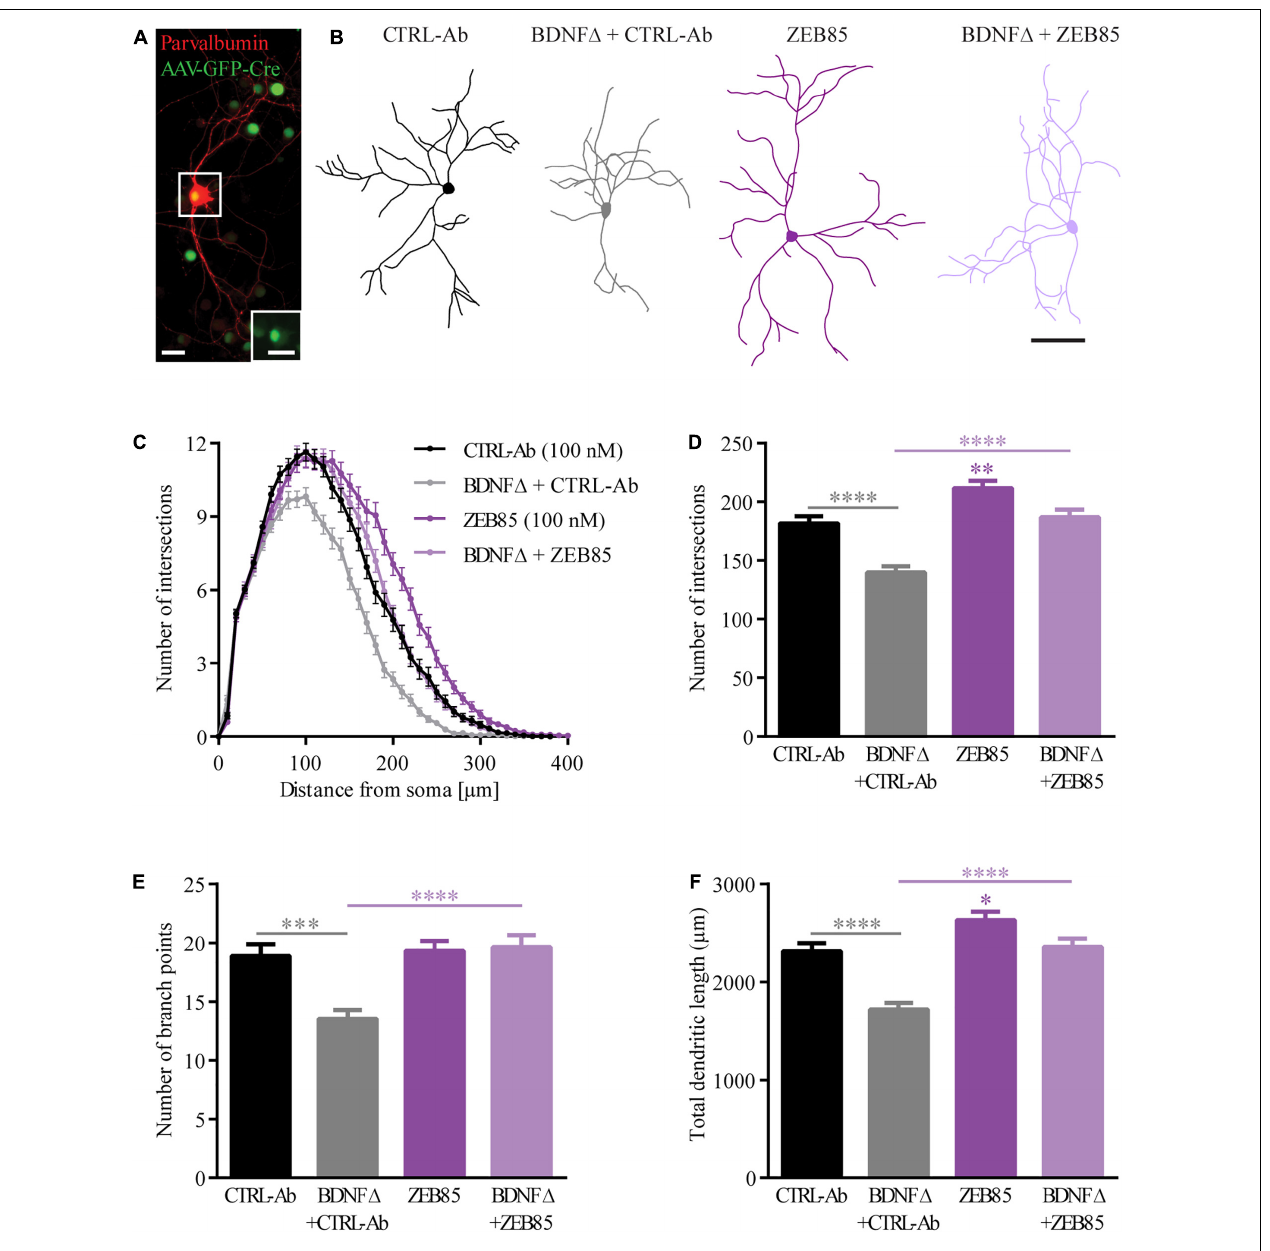
FIGURE 2 | ZEB85 rescues the dendritic complexity of bdnf-KO PV+ interneurons. (A) Representative image of an AAV-CRE-GFP transduced parvalbumin-positive (PV + ) interneuron in primary BDNF fl / fl hippocampal cultures. The inserted image (dotted square) shows the nuclear GFP expression of the transfected PV + interneuron. Both scale bars, 25 µ m. (B) Neurolucida tracings used for Sholl analysis from PV + interneurons DIV21 treated at DIV0 with ZEB85 (100 nM) or control-antibody (CTRL-Ab) either BDNF-depleted (BDNF (cid:49) ) or not. Scale bar, 100 µ m. (C) Sholl analysis curves, with the number of intersections plotted against the distance from the cell body. Graphs show the (D) total number of intersections, (E) number of branch points and (F) total dendritic length of PV + interneurons. (CTRL-Ab, ZEB85 and BDNF (cid:49) + ZEB85: n = 74 neurons; BDNF (cid:49) + CTRL-Ab: n = 75; N = 3 independent experiments). The data are presented as mean ± SEM and were tested using a (C) repeated measures two-way ANOVA and (D–F) one-way ANOVA with Bonferroni post-test. ∗ p < 0.05; ∗∗ p < 0.01; ∗∗∗ p < 0.001; ∗∗∗∗ p < 0.0001.